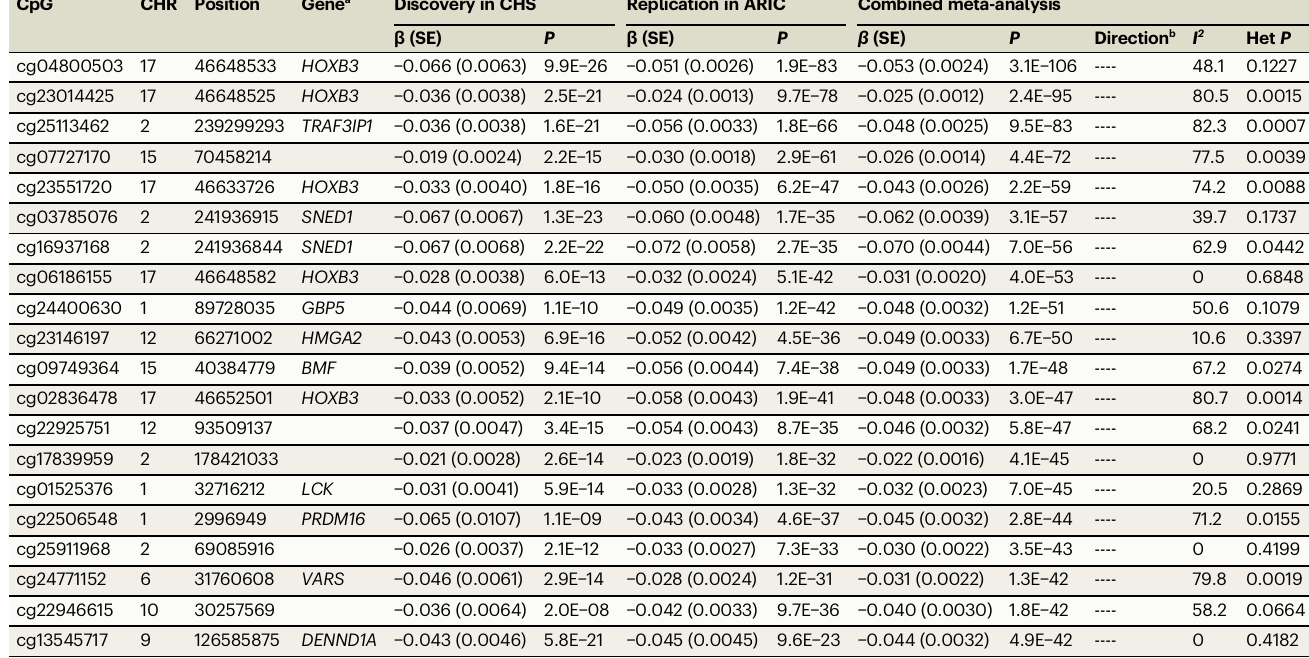
Table. 2 | Top 20 DNMT3A -CHIP-associated CpGs CpG CHR Position Gene a Discovery in CHS Replication in ARIC Combined